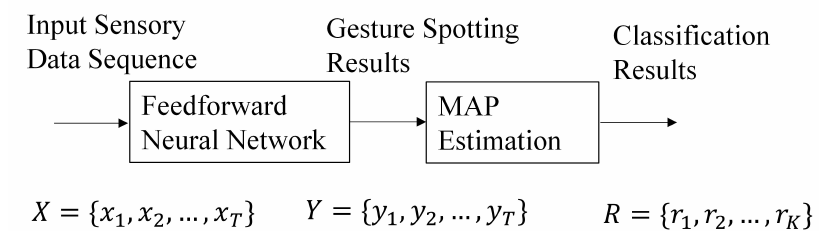
Figure 1. The overview of the proposed gesture recognition system, where X , Y , and R denote the input sensory data, gesture spotting results, and classification results, respectively.